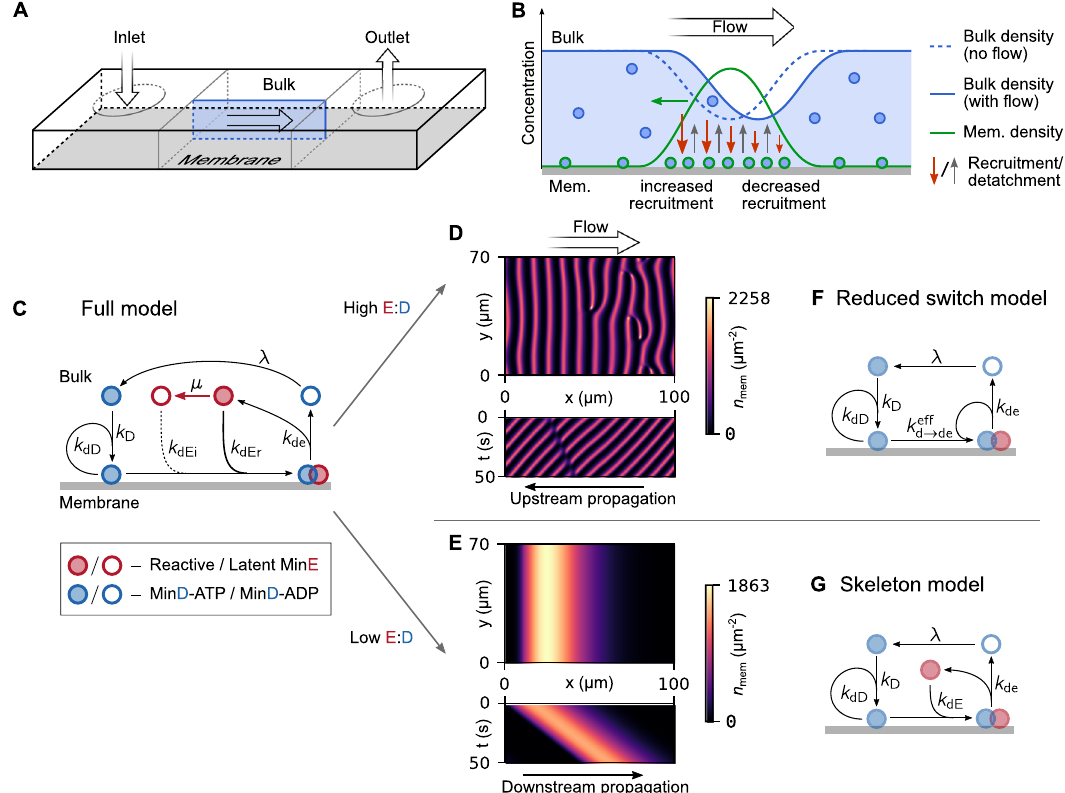
Fig. 1 | Min models and simulation results. A Basic illustration of setup used for simulations as well as experiments. B Illustration of the effect of bulk fl ow on patternformation.MinDadvectioninthebulkshiftsitsconcentrationpro fi leinthe bulk relative to the membrane pattern, leading to an increase in the bulk con- centration on the upstream side of wave crests relative to the downstream side. This enhances the recruitment rate (green arrows)on the upstreamsiderelativeto thedownstreamsideandthus,resultsinamovementofthemembranepattern(but not the individual proteins) in the upstream direction. C Diagram depicting the interactions in the full switch model. This model includes the MinE switch. MinD-